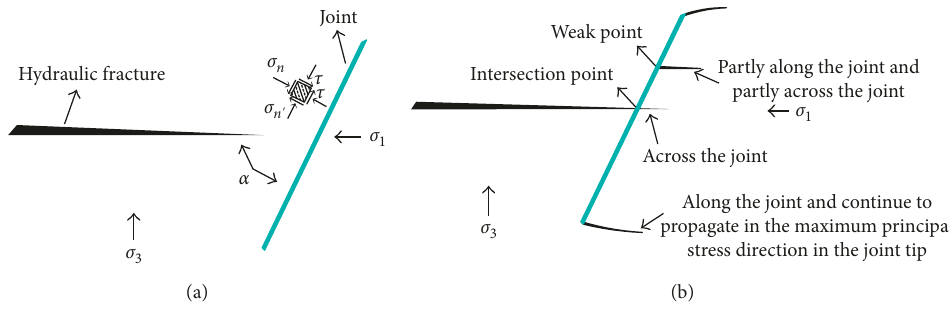
Figure 6: Reaction of joint on hydraulic